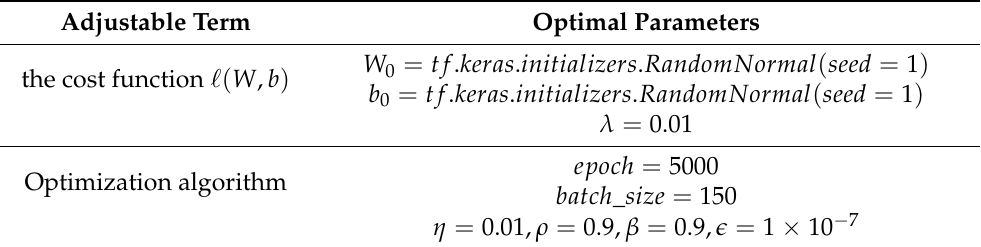
Table 9. Optimal parameters for algorithm debugging determined by GridSearchCV